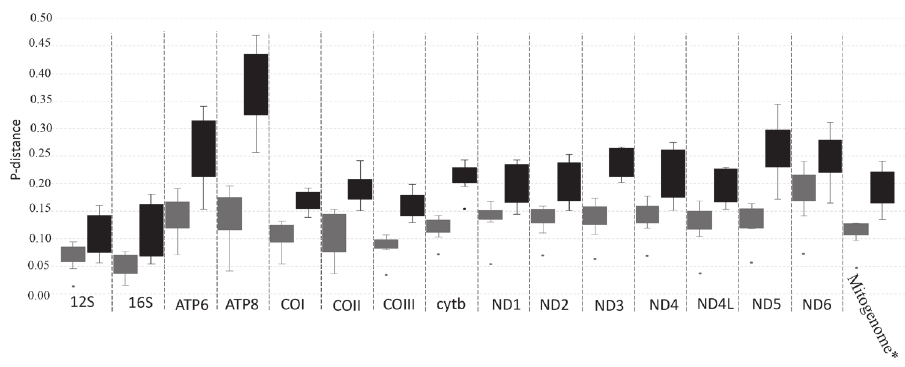
Figure 10 . The mean partwise interspecific (gray) and intergeneric (black) p-distance in each